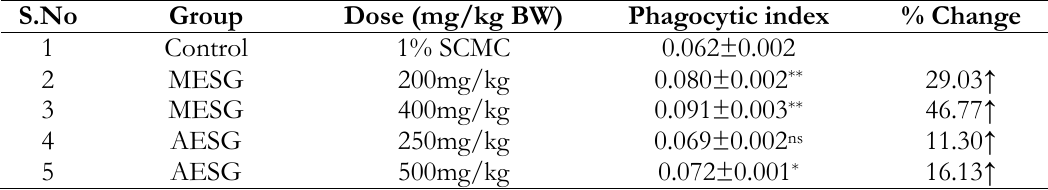
Table II. Effect of Sesbania grandiflora flowers on Phagocytic index. S.No